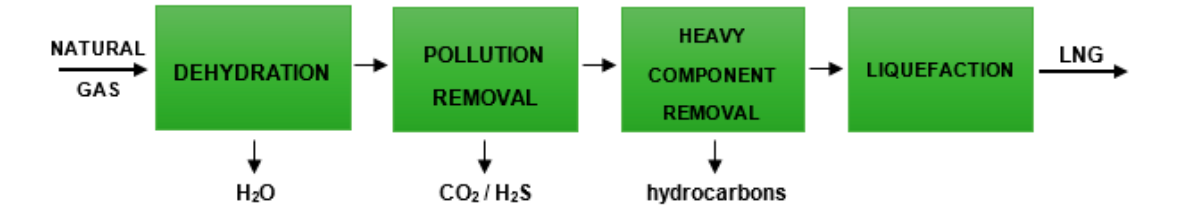
Figure 2. Liquefied natural gas (LNG) production process.